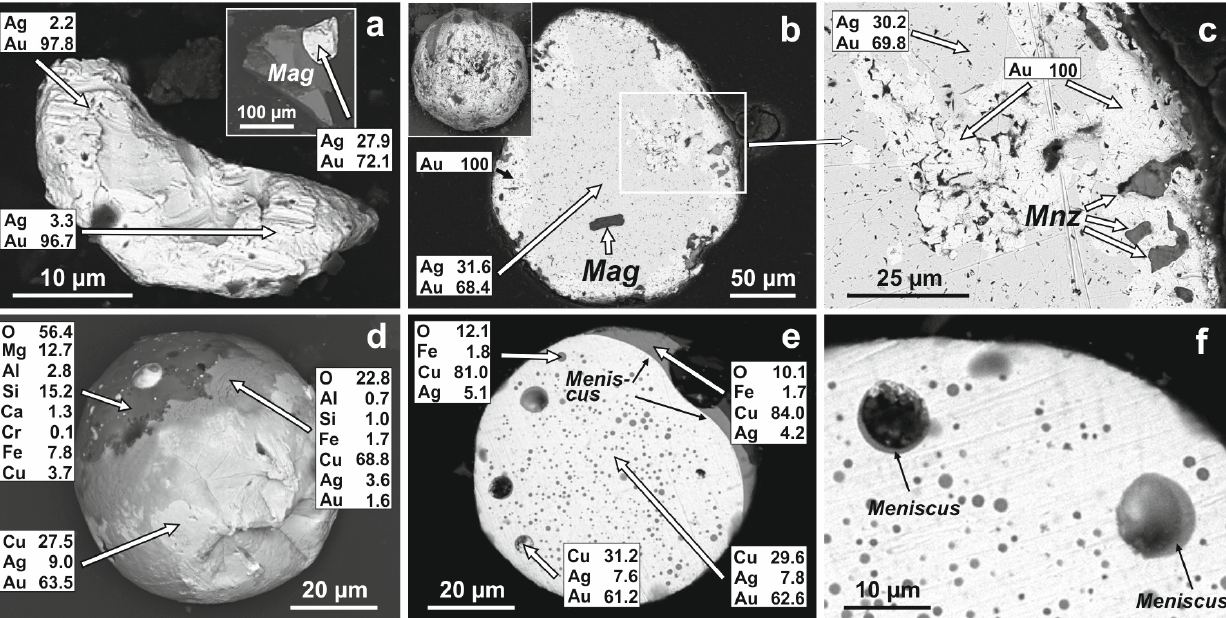
Figure 10. Gold-bearing grains in basaltic intrusion from the Poperechnoye deposit: ( a )—shapeless particle with partially preserved original magmatic crystal faces and gold-silver alloy in association with magnetite (Mag) (inset); ( b , c )—rounded particles (micro-spherules) with pure gold rims and inclusions of euhedral magnetite (Mag) ( b ) and monazite (Mnz) ( c ); ( d )—Cu-Ag-Au micro-spherule with compaction-related deformations and copper oxide and magnesium-silicate outer shell (rim); ( e , f )—internal structure of the spherule in ( d ) with abundant spherical cavities and copper-oxide micro-inclusions. Surface of the spherule ( e ) and some larger internal cavities ( f ) exhibit clear and sharp meniscus-like boundaries indicative of liquid immiscibility.